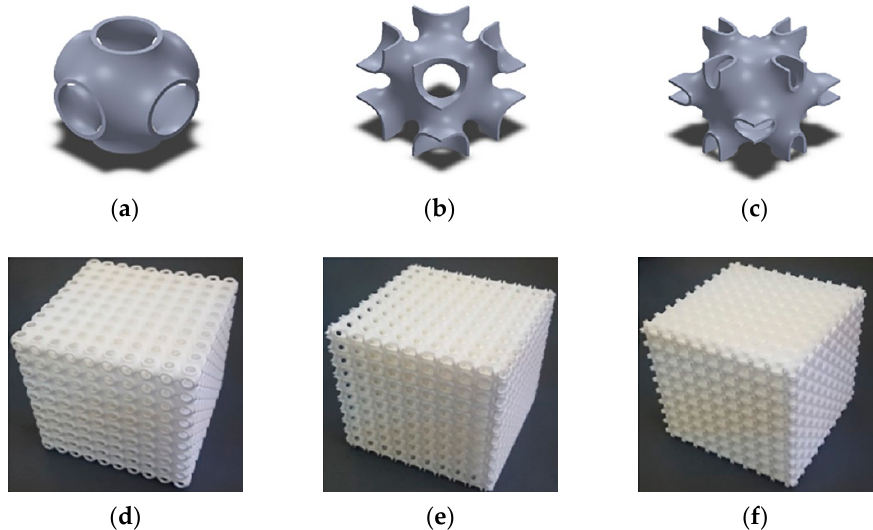
Figure 3 . The first row shows computer-aided designs of gyroid structures while the second row shows corresponding printed cellular structures with a relative density of 10%. ( a ) Primitive-Cellular Materials (CM), ( b ) IWP (I-graph and Wrapped package-graph)-CM, ( c ) Neovius-CM. 3D printed specimens: ( d ) Primitive-CM (relative density is 23.5%), ( e ) IWP-CM (relative density is 25.6%), ( f ) Neovius-CM (relative density is 23.7%). Reprinted with permission from ref. [216] . Copyright 2017,